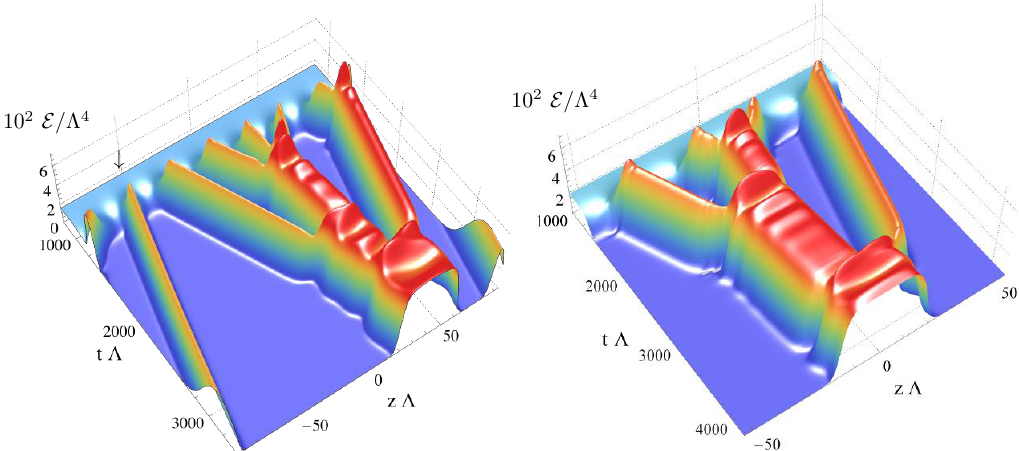
Figure 11 . Zoom in of (cid:12)gure 4. At the end of the reshaping period seven peaks form on the left plot and four on the right one. Snapshots at those times are shown in (cid:12)gure 8 in dashed green. From that point on, the peaks move rigidly with almost constant shapes at slowly varying velocities. They subsequently collide and merge, forming larger structures. Eventually, all the structures merge into a single one and the system reaches a phase-separated con(cid:12)guration (see (cid:12)gure 4). The peak indicated with an arrow on the left plot corresponds to the peak shown in (cid:12)gure 12.